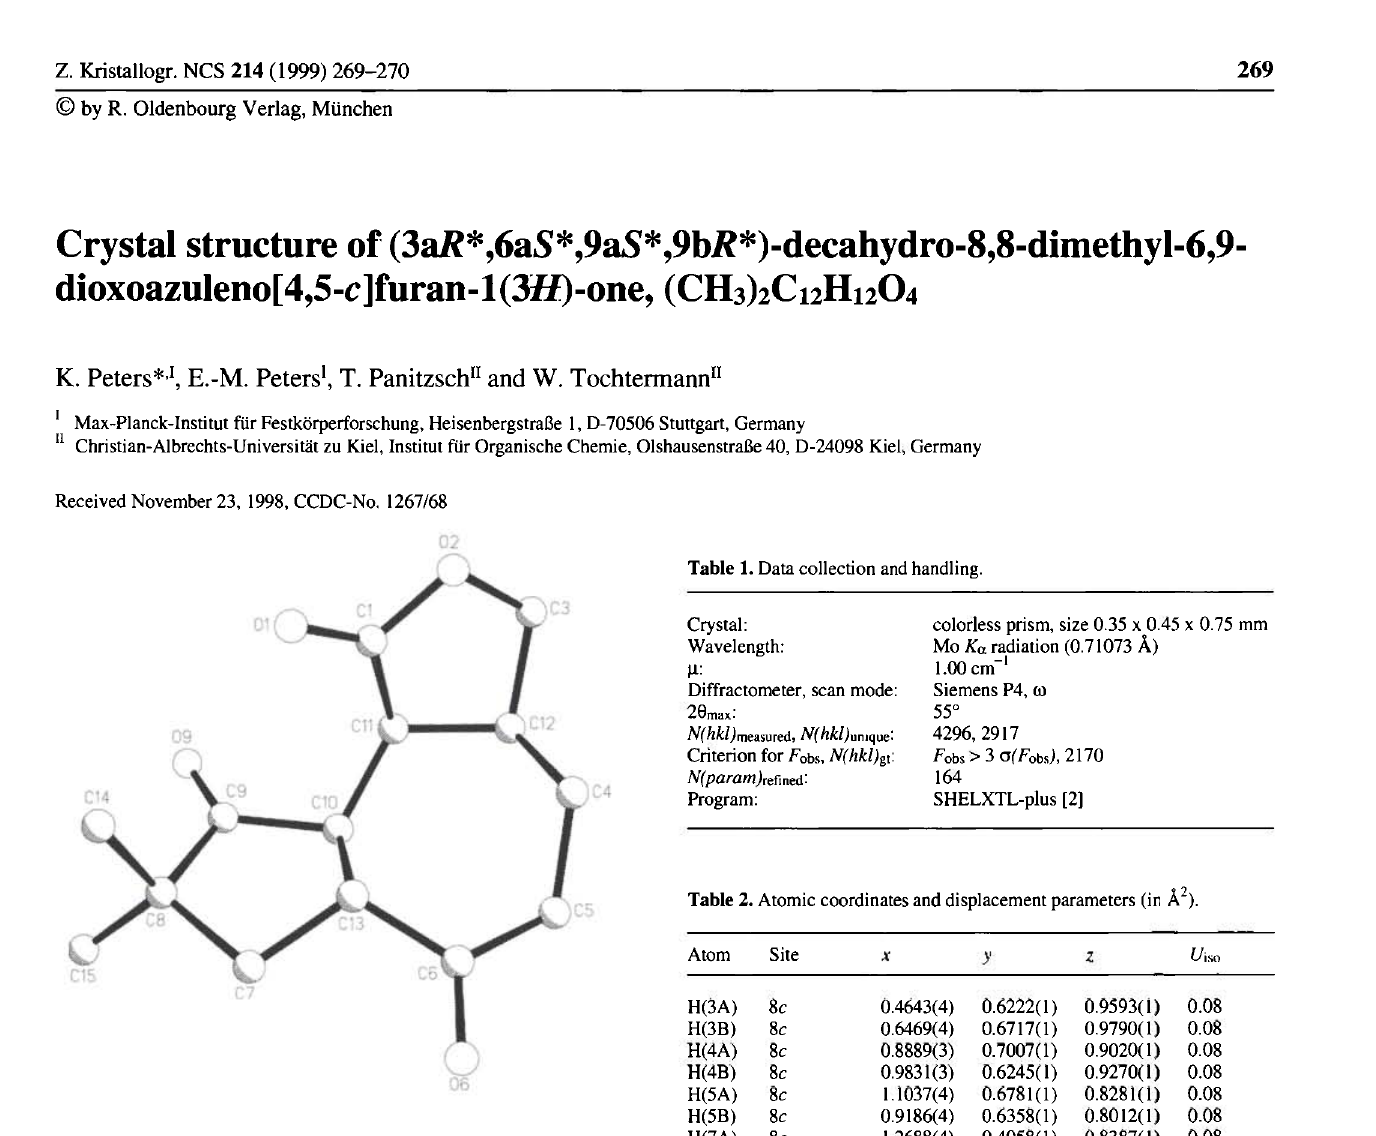
Table 2. Atomic coordinates and displacement parameters (in